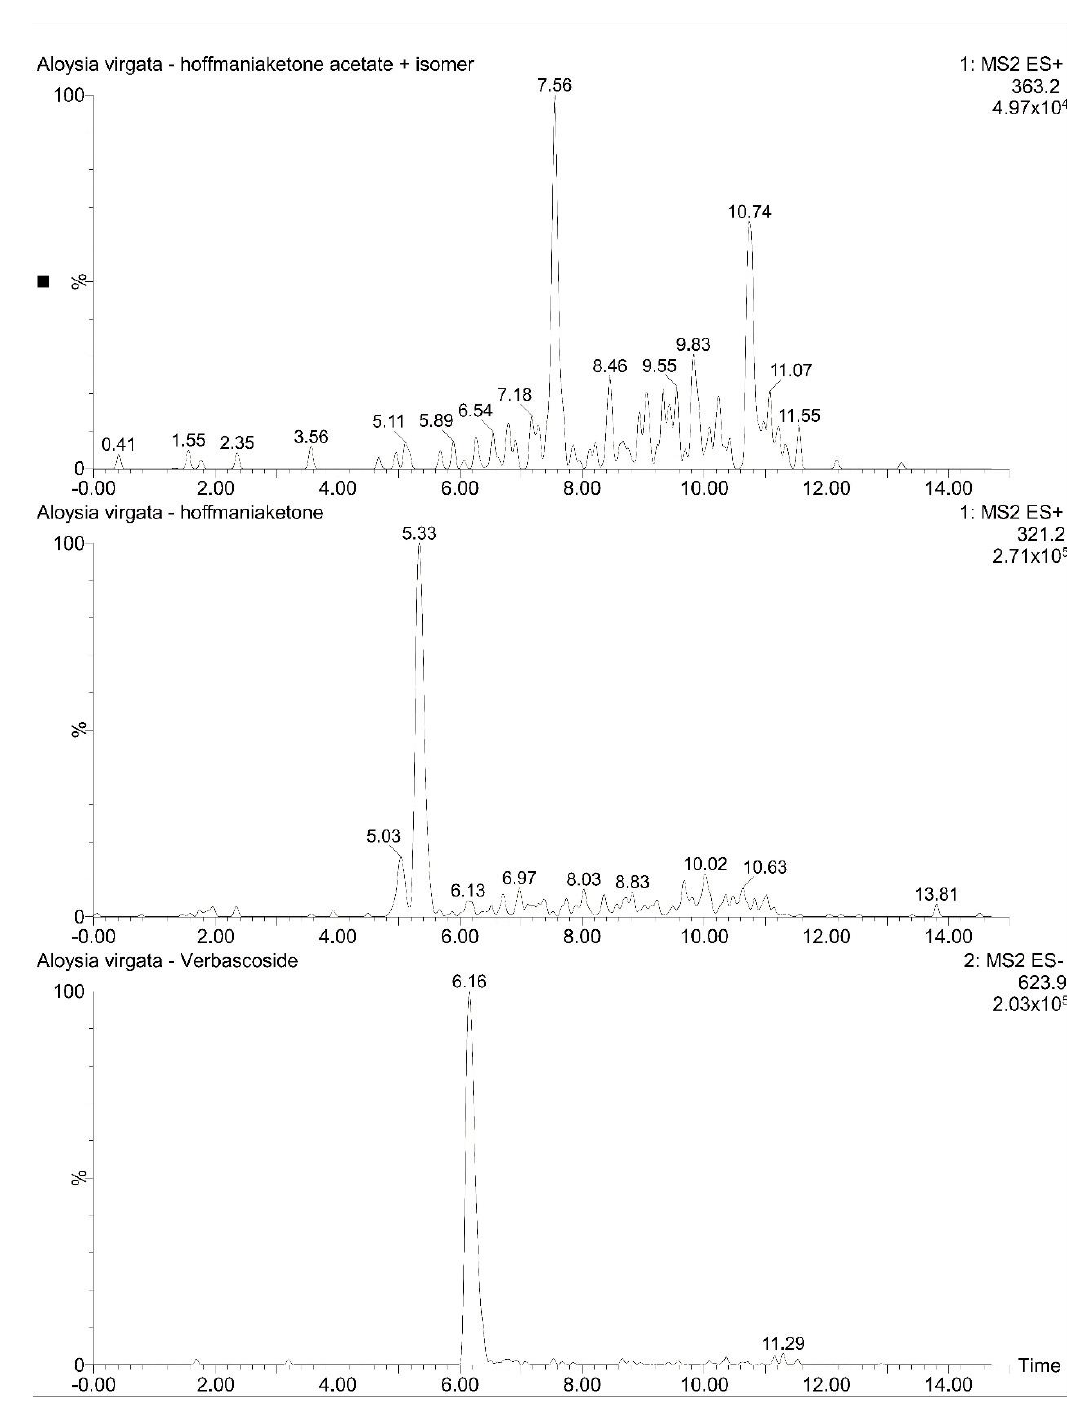
Figure 9. Extracted ESI-LCMS ion chromatograms of compounds from Aloysia virgata var. platyphylla .